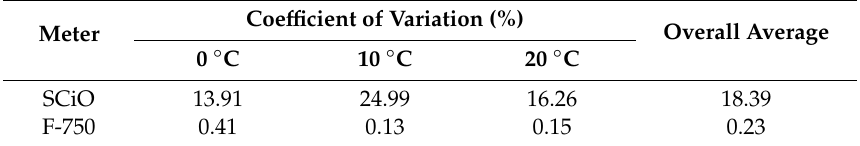
Table5. Summaryoftheaveragecoe ffi cientofvariationofmeasuredTeflonspectrainabsorbancevalues. Coe ffi cient of Variation (%) Table 5. Summary of the average coefficient of variation of measured Teflon spectra in absorbance Meter values. Coefficient of Variation (%) Meter Overall Average